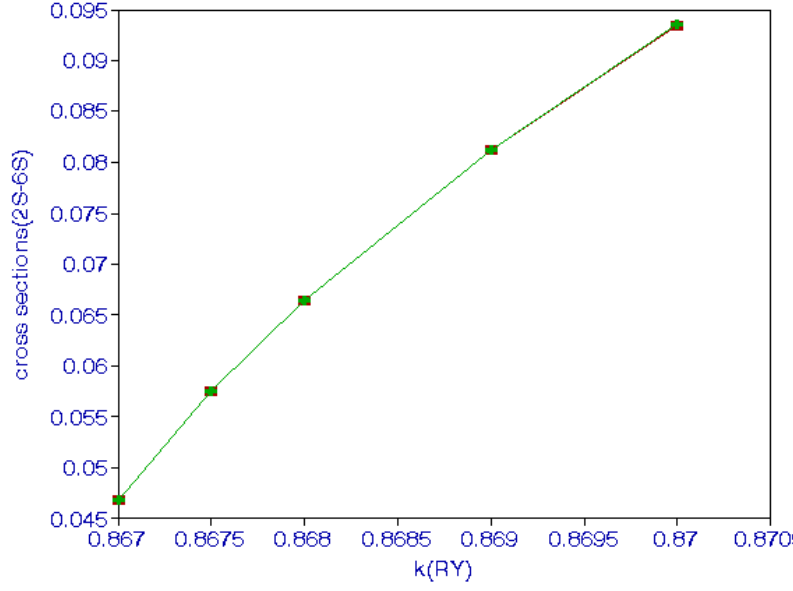
Figure 1. (Color online) Total excitation cross sections as a function of the incident k to nS states, n = 2 to 6.